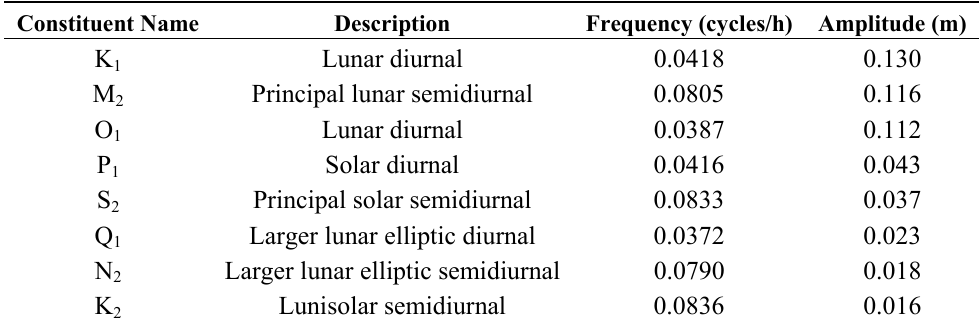
Table 1. Dominant tidal constituents at the Apalachicola